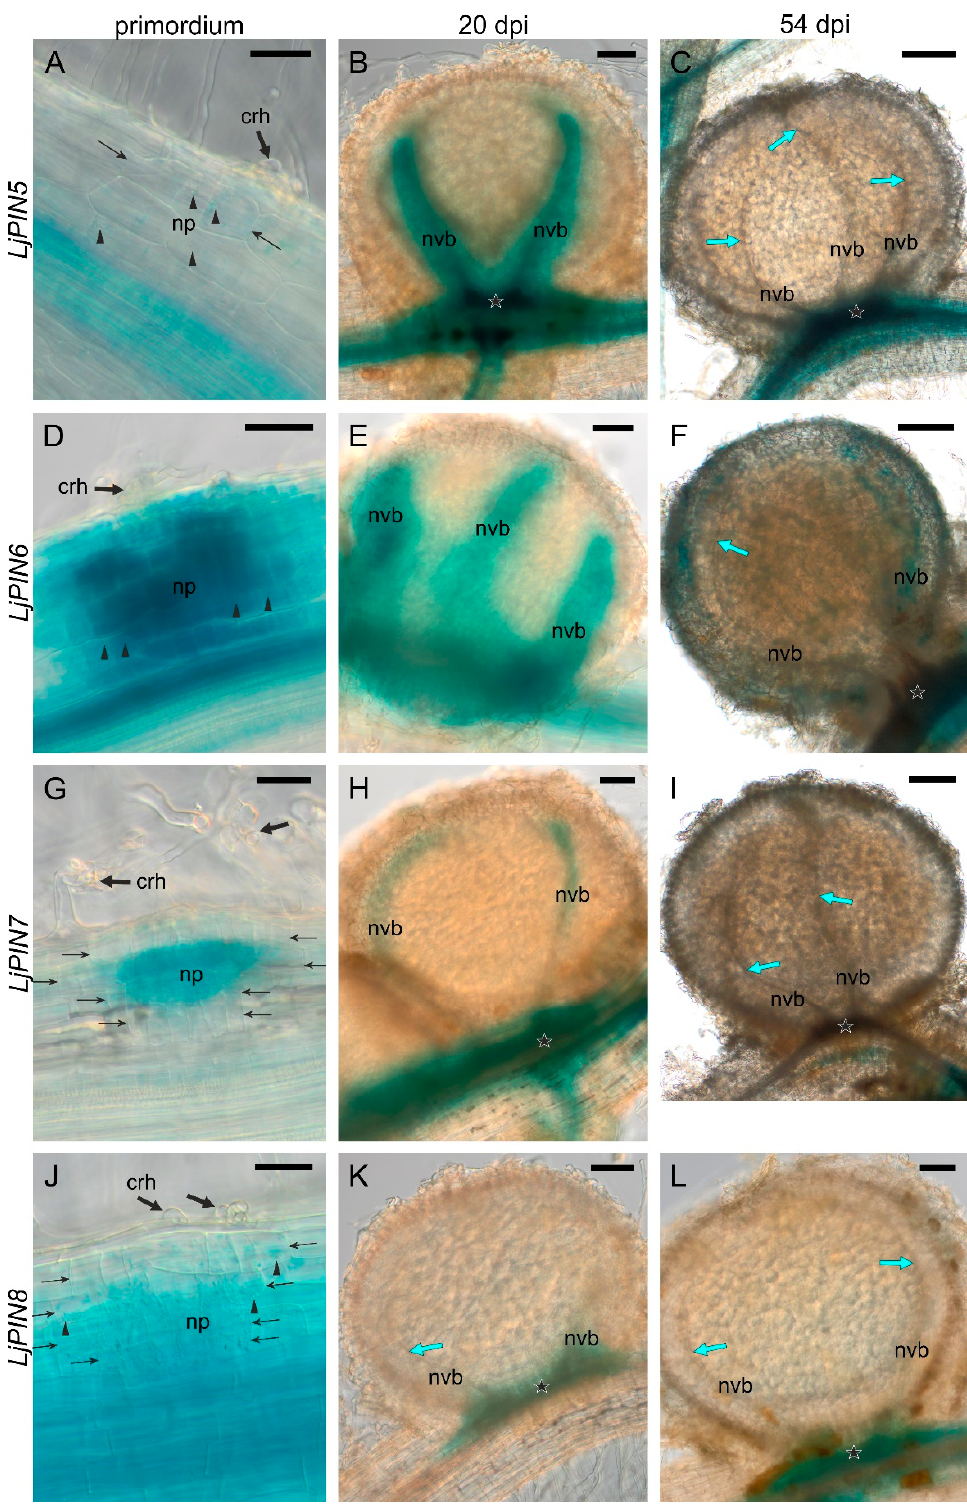
Figure 4. Expression patterns of LjPIN5 , LjPIN6 , LjPIN7 , and LjPIN8 in nodule primordium ( A , D , G and J —respectively), 20 dpi nodule ( B , E , H and K —respectively) and mature, 54 dpi nodule ( C , F , I , L —respectively), obtained by GUS histochemical assays performed on transgenic roots. np—nodule primordium; crh—curled root hair; nvb—nodule’s vascular bundle; black thin arrows—cells of root cortex in the division; arrowheads—starch; blue arrows—tracheal elements; stars—vascular connection between root’s stele and nodule. Bars: 50 µ m ( A , D , G , J ), 100 µ m ( B , E , H , K , L ), 200 µ m ( C , F , I